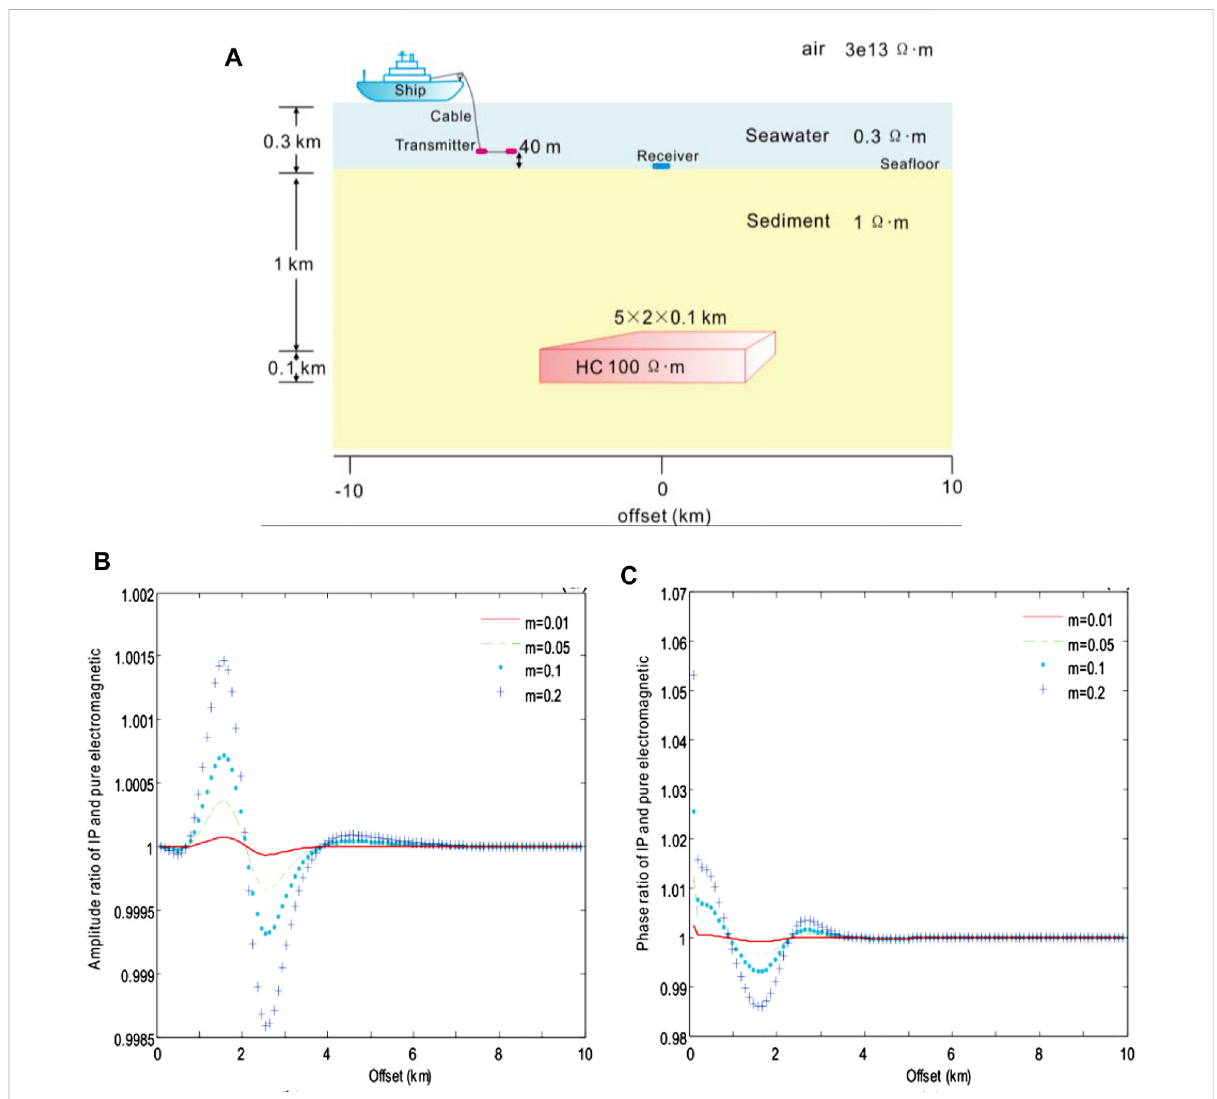
FIGURE 8 Amplitude and phase ratio of CSEM with the IP and pure electromagnetic fi eld to the Dias model of various polarizability m = 0.01 (red), 0.05 (green),0.1(blue),and0.2(lightblue),respectively. (A) Geoelectricmodelofsubmarinehydrocarbonswithion-inducedpolarizationinthe3Dmarine CSEM, (B) the ratio of amplitude, and (C) the ratio of